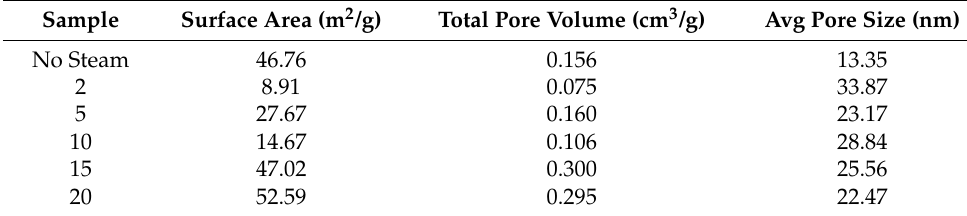
Table 1. Effect of hydration for surface area and pore volume parameters of